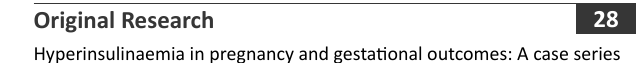
Editorial Interpreting quantification: Is this the Achilles heel of insulin